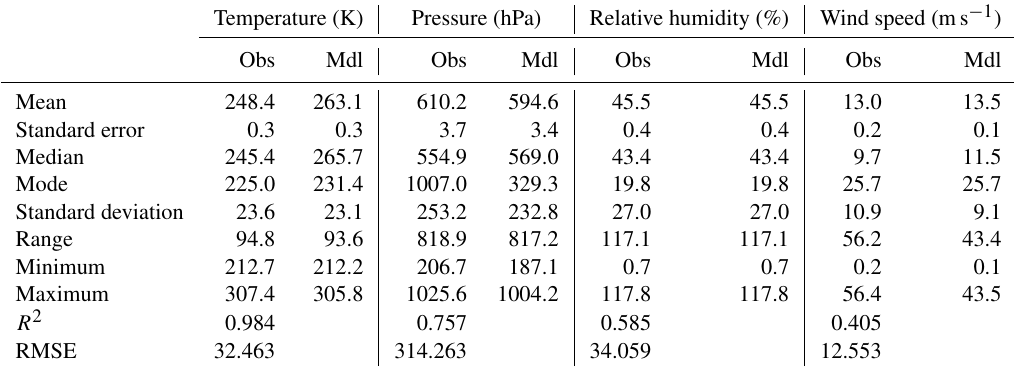
Table 2. Statistical summary of comparison of observed and modeled meteorological parameters for NASA ARCTAS spring and summer flights. Obs and Mdl denote observation and model data. RMSE stands for root mean square